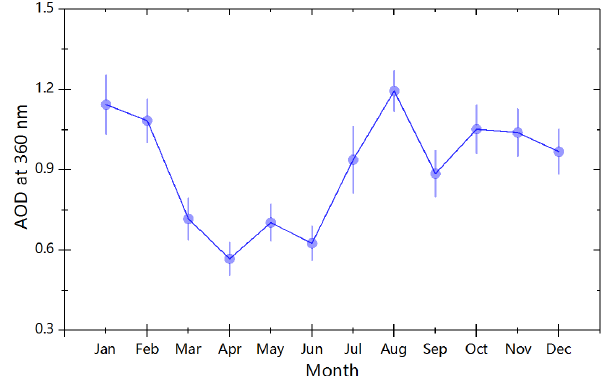
Figure 5. Time series of monthly AOD from December 2017 to February 2019 at CAS